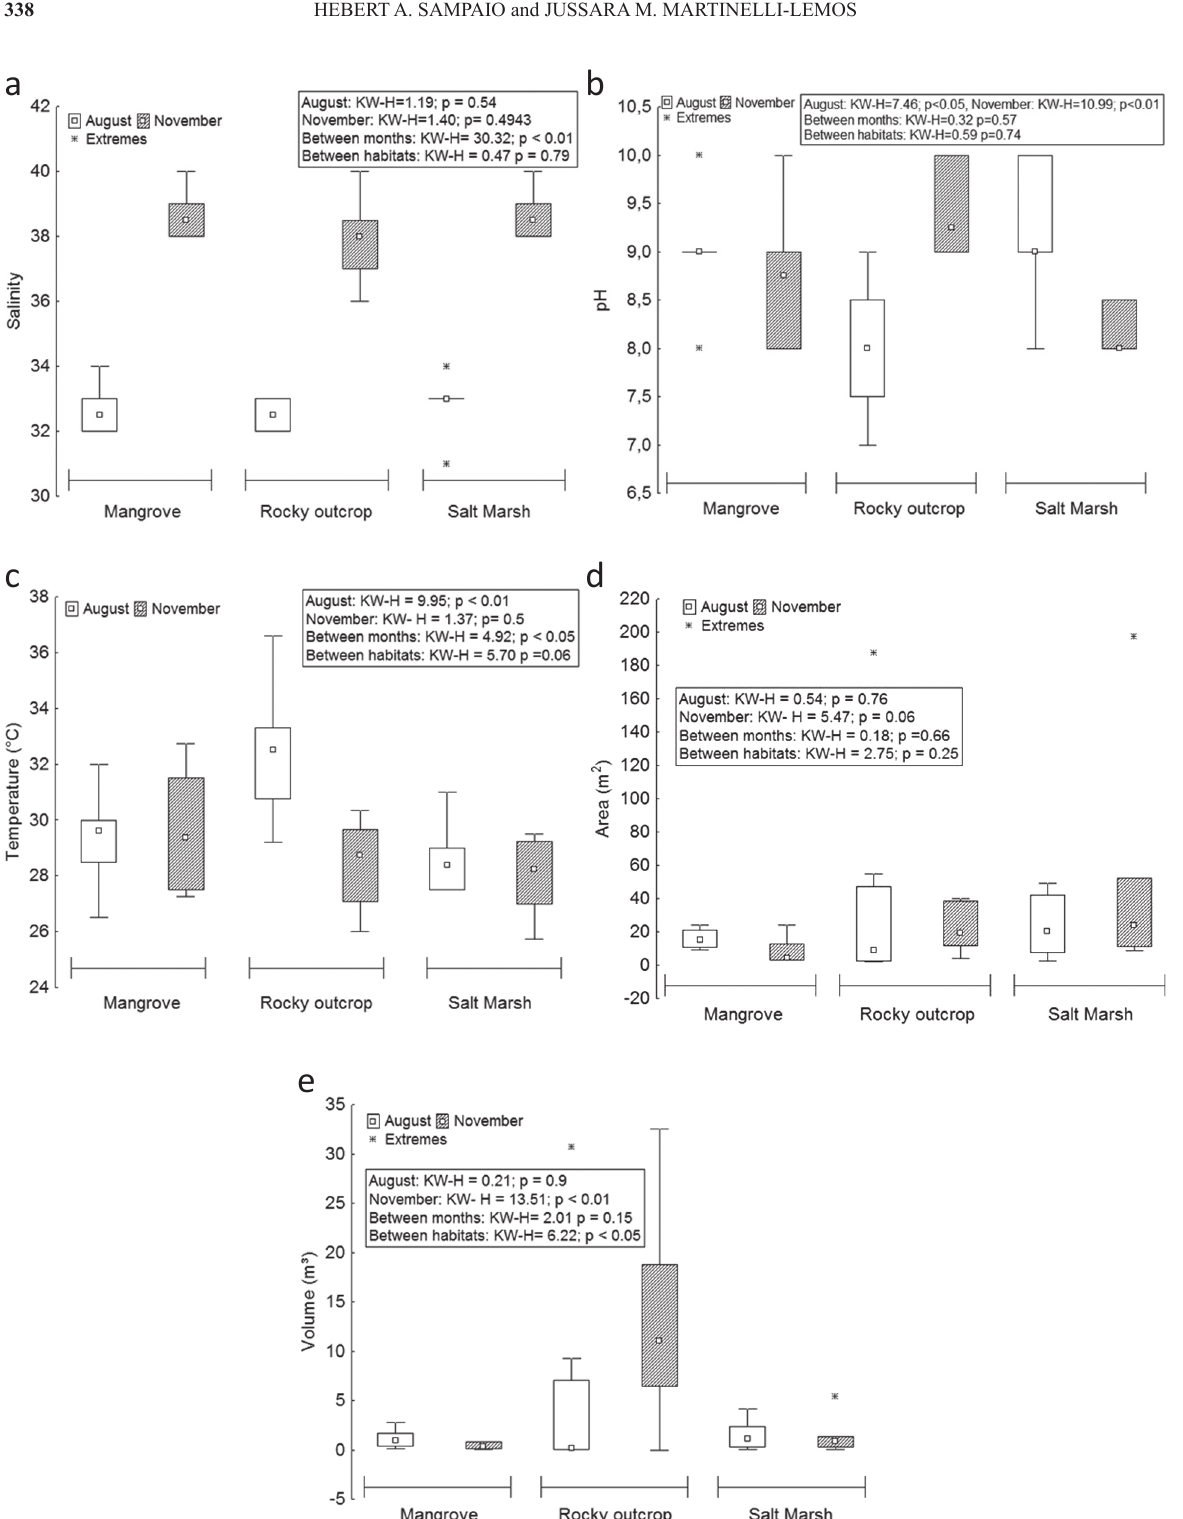
Figure 3 - Variation of abiotic factors (temperature, pH, salinity, area and volume) of tide pools in three different habitats of Areuá Beach, Guarás Island, Curuçá, Pará, Brazilian Amazon. A = salinity; B = pH; C = temperature; D = area; and E =